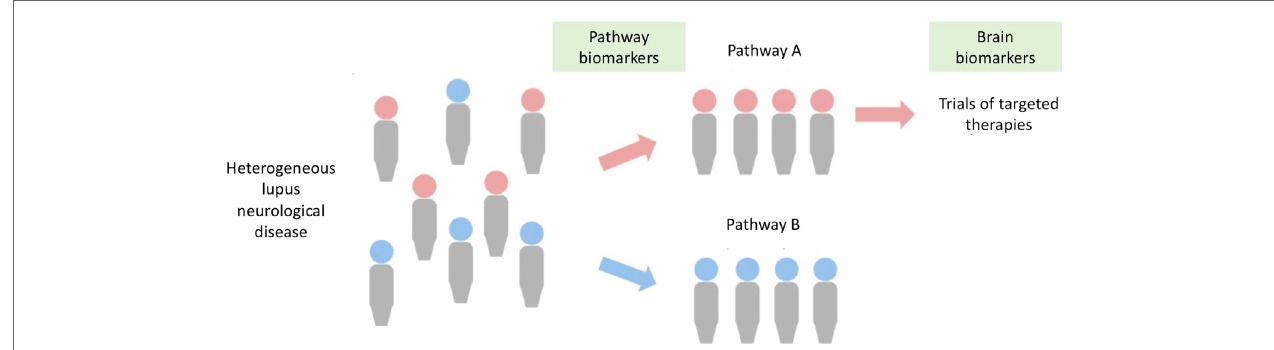
FigURe 4 | A stratified medicine approach for neurolupus. Brain disease in lupus is clinically heterogeneous (left), but may be driven by certain molecular pathways (e.g., type I interferon pathway, pathogenic autoantibodies), allowing stratification of populations. Improvements in biomarkers will allow identification of aberrant pathways in patients, such that they can be directed to clinical trials targeted at the specific pathway. Central to the success of such a strategy is the development of brain biomarkers (e.g., magnetic resonance imaging scans, markers of brain damage) to supplement clinical